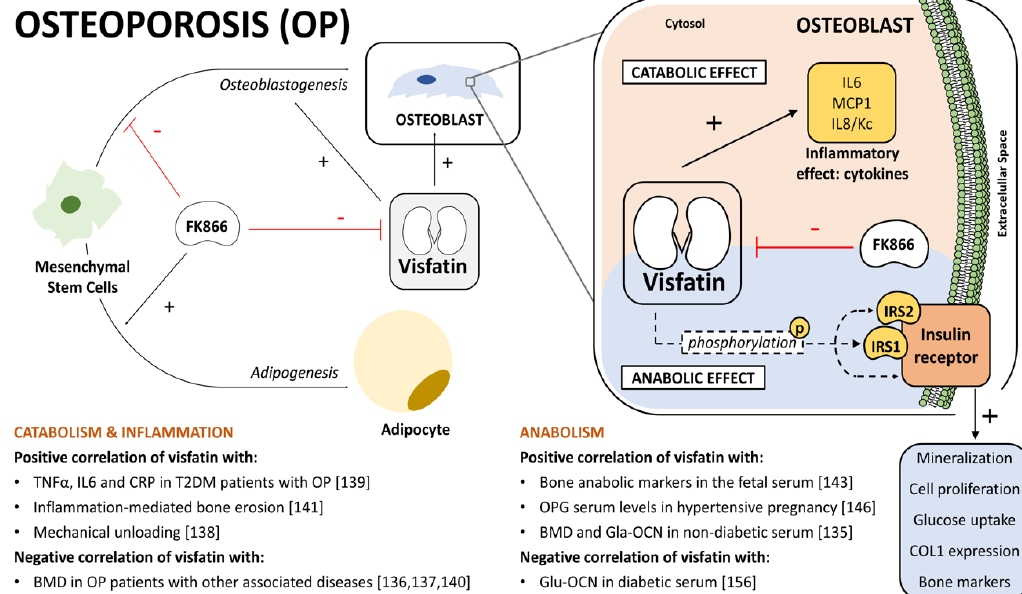
Figure 4. Visfatin Role in Osteoporosis (OP). Visfatin is involved in OP. Visfatin exhibits opposing effects on bone metabolism. It induces anabolic responses and also catabolic responses linked to inflammation and other diseases. Visfatin promotes the osteoblastogenesis process as well as anabolic effects on osteoblasts. Nonetheless, it also promotes certain inflammatory responses in these cells. Bone mineral density (BMD); carboxylated osteocalcin (Gla-OCN), uncarboxylated OCN (Glu-OCN); tumor necrosis factor α (TNF α ); interleukin 6 (IL6); C-reactive protein (CRP); interleukin 8 (IL8), also known as chemokine (Kc); monocyte chemoattractant protein 1 (MCP1); insulin receptor substrates 1 (IRS1) and 2 (IRS2); collagen 1 (COL1).